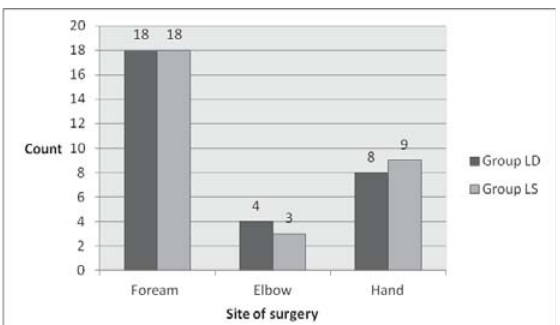
Figure 3. Distribution of the patients according to the site of